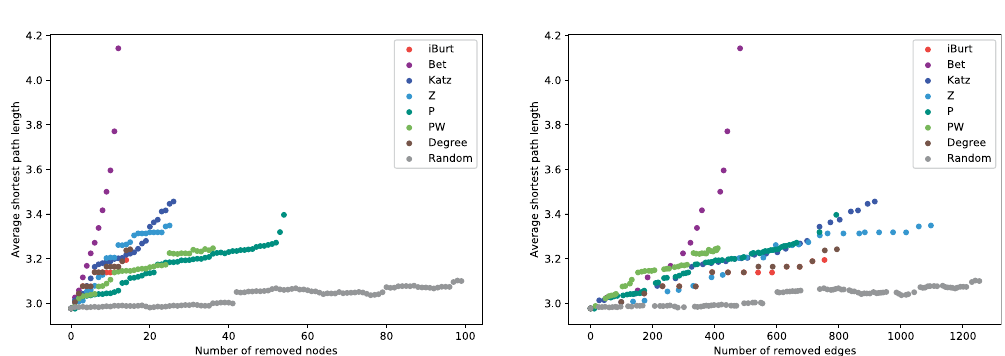
Figure 6. Changes in the diameter after the attack. The vertical axis represents the average shortest path length of the Tohoku network after the attack, and the horizontal axis is the cumulative number of the nodes (left figure) and the edges (right figure) that was removed after each attack. At every attack, we re-calculated the node values and we stopped the attack when the network was divided from the largest